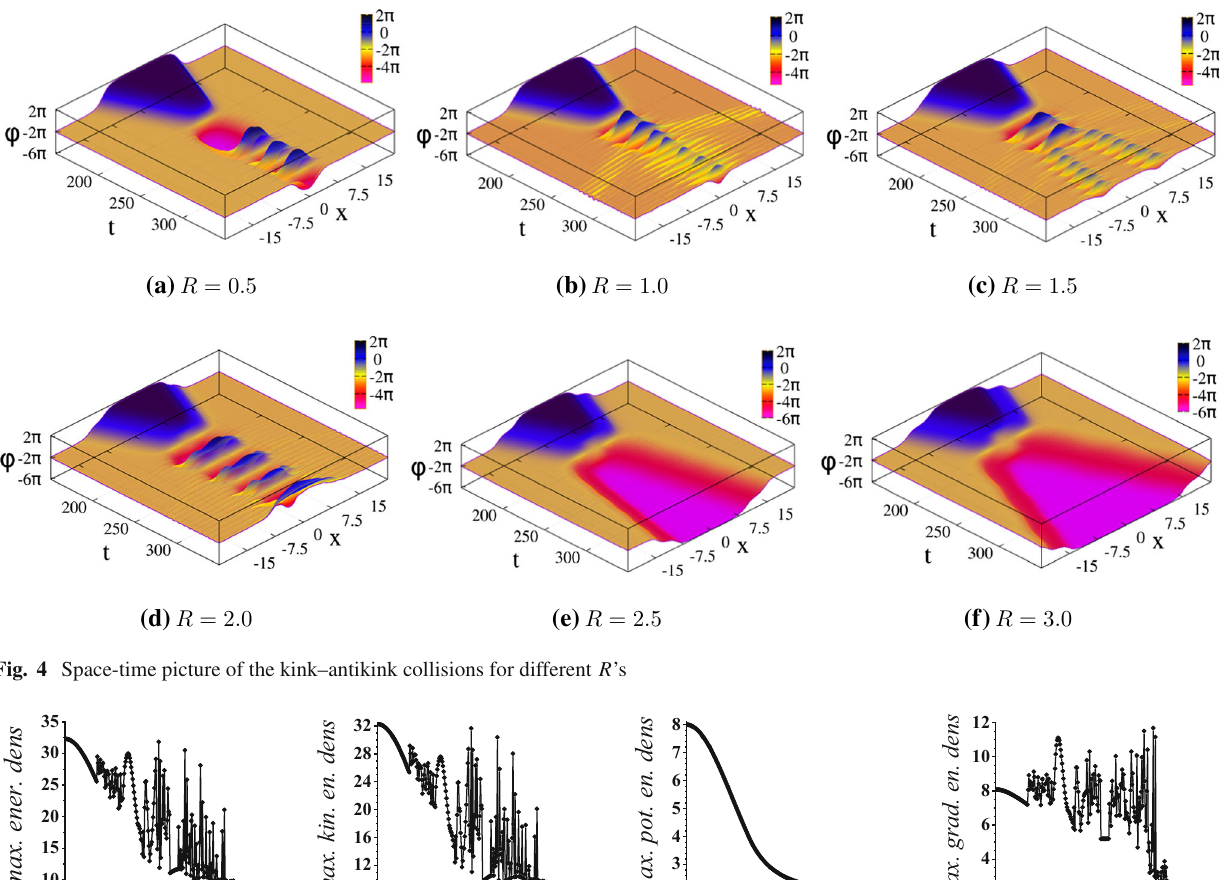
0.0 0.5 1.0 1.5 2.0 2.5